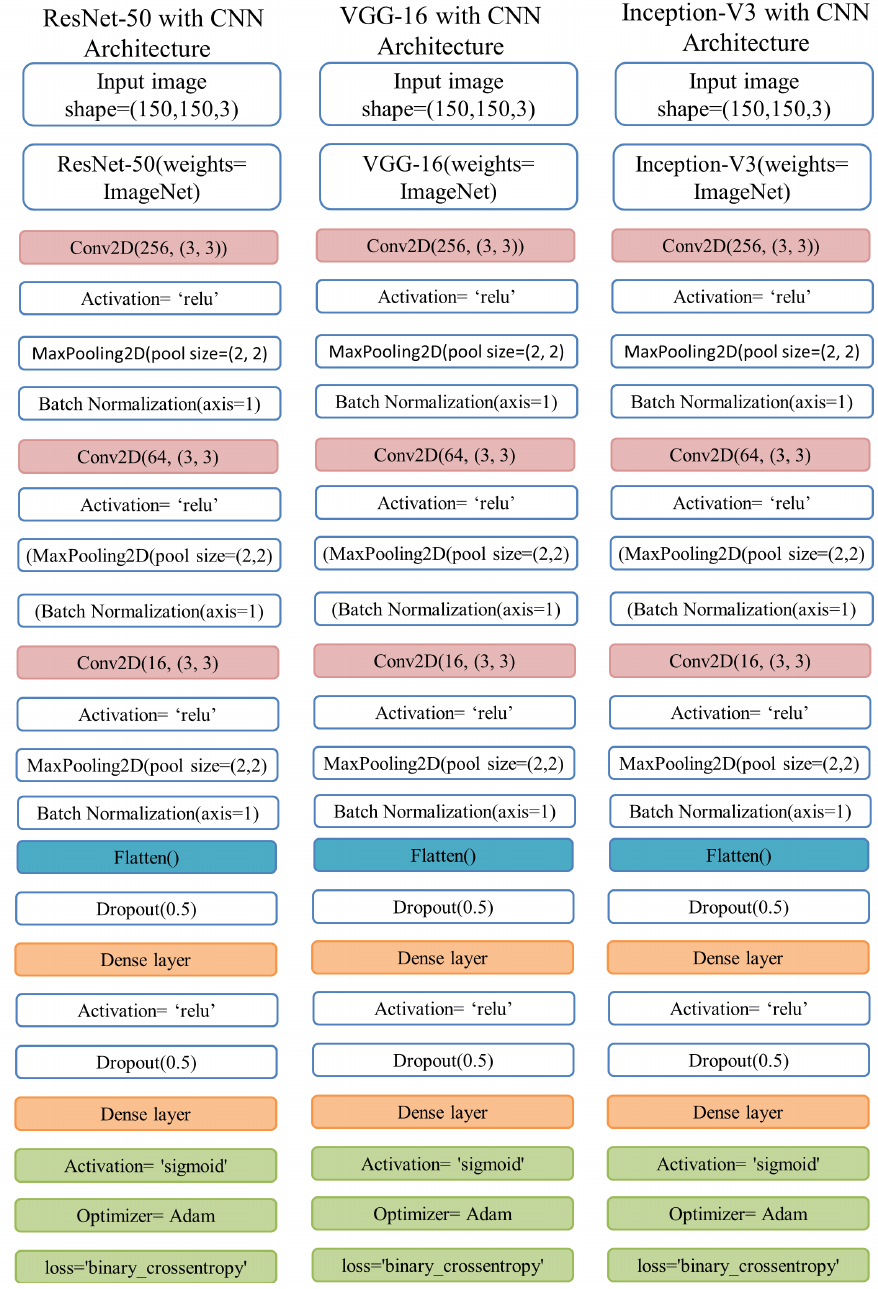
Figure 4. Architecture of three ensemble models used in this